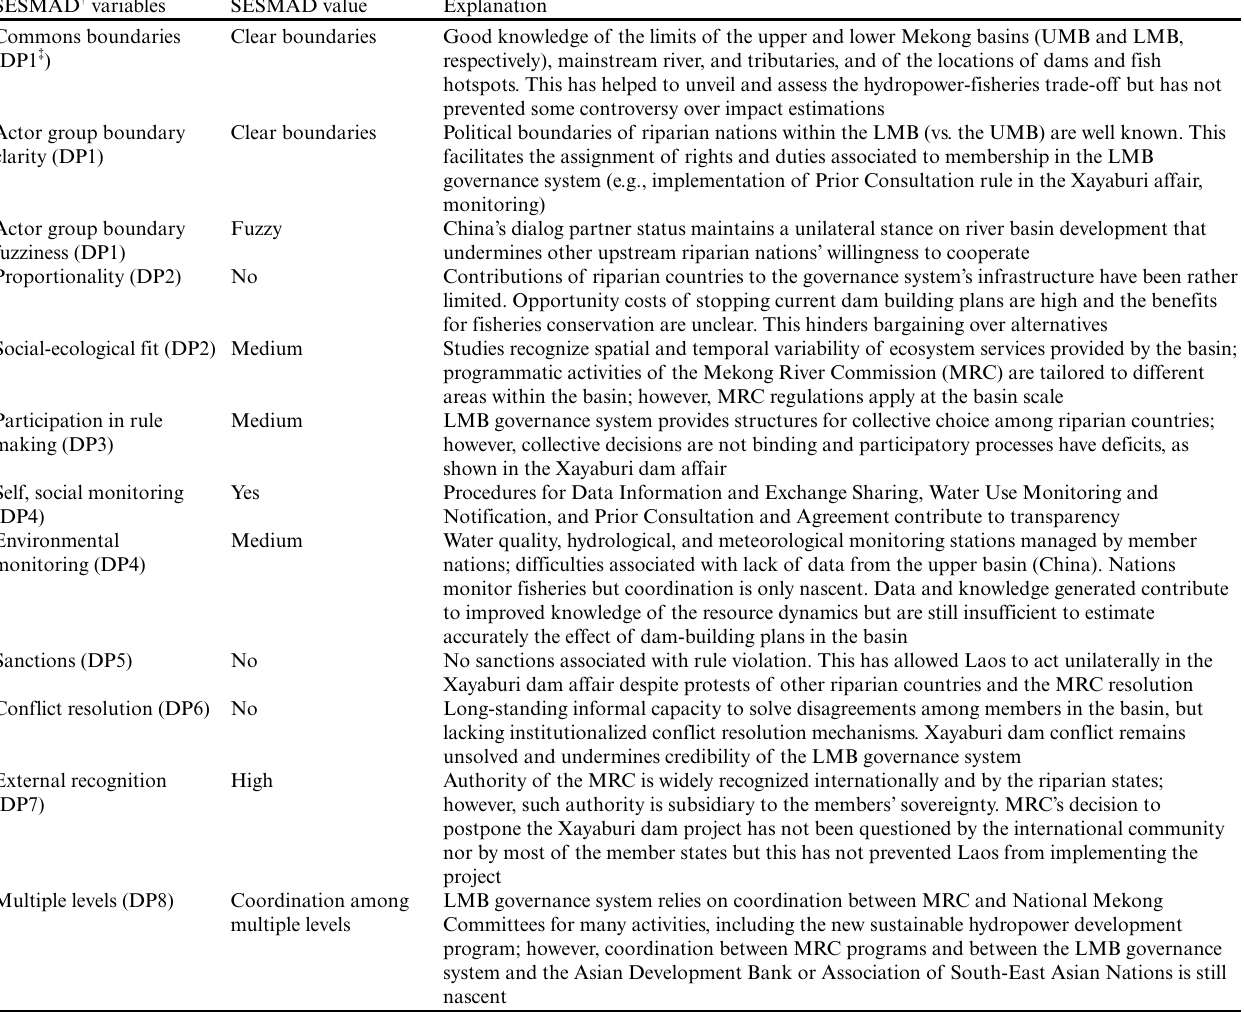
Table 4. Coding and relevance of Ostrom’s design principles in the lower Mekong basin